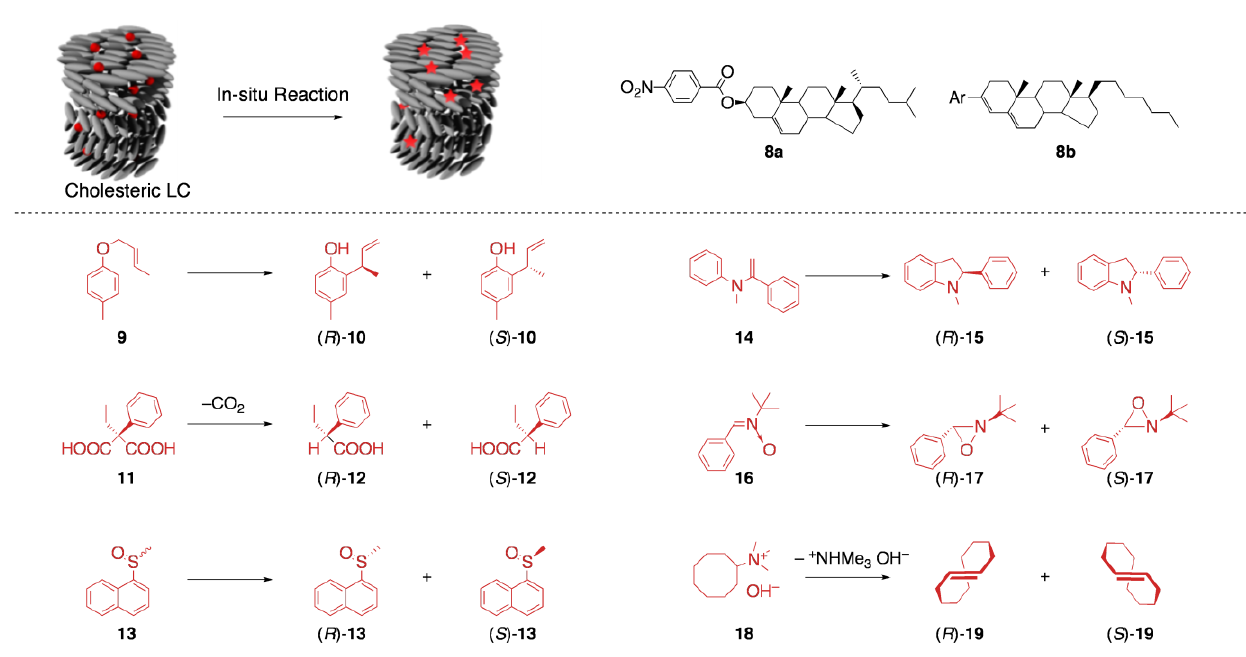
Figure 9. Asymmetric synthesis in cholesteric